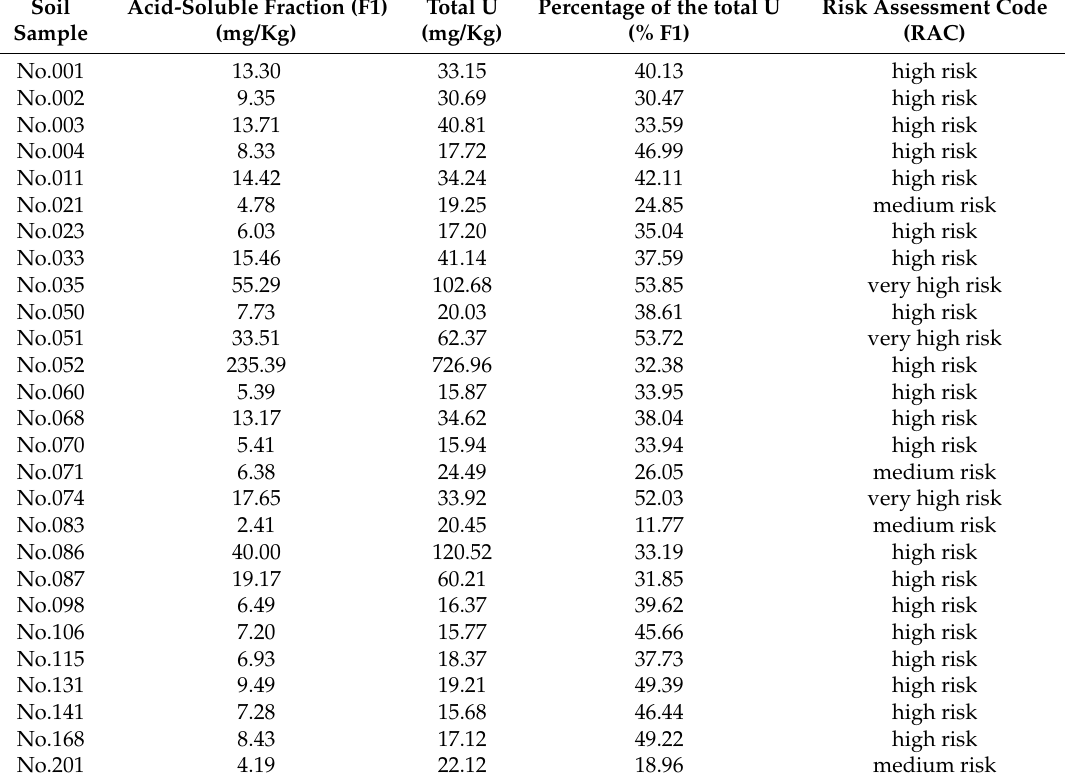
Table 3. Acid-soluble fraction (F1), %F1 and uranium’s RAC of the 27 samples.